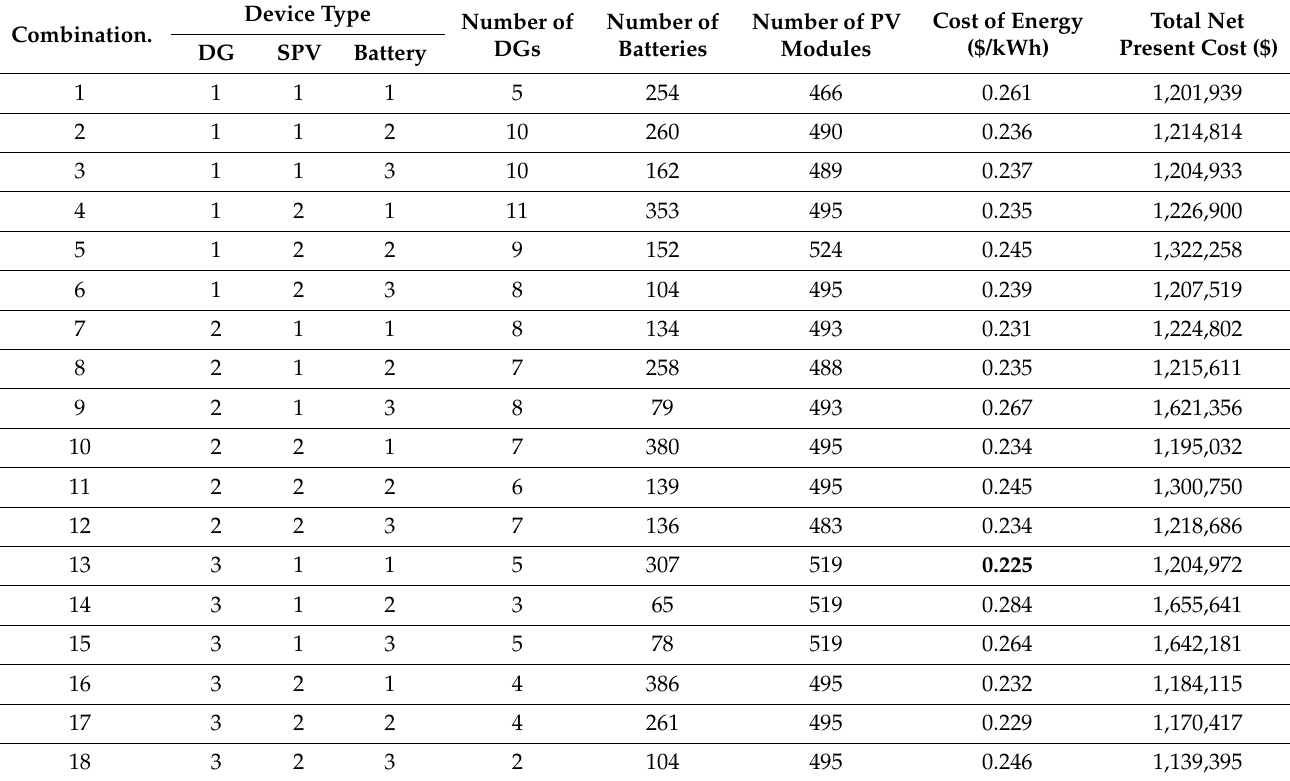
Table 1. Optimum size for each combination of hybrid